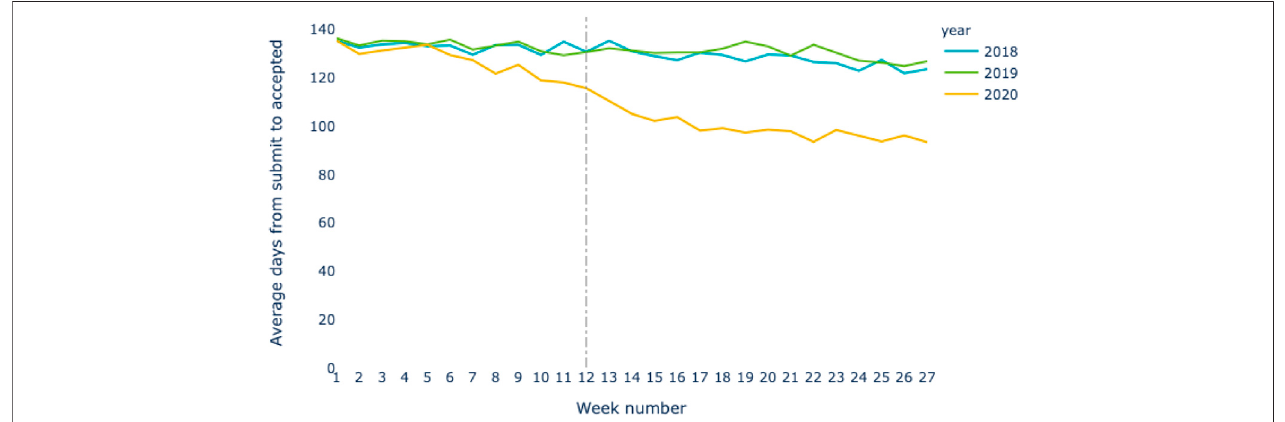
FIGURE2| Averagedaysbetweensubmissionandaccepteddates.Thedottedlineindicatesweek12,mid-March2020,wheremostoftheworldstartedentering in some form oflockdown, and schoolswere shutdown. Foreach week shown inthe plot, the number ofpapersthat have been accepted aretaken and then amount of time taken since acceptance is calculated. The average time from submission to acceptance is then taken.